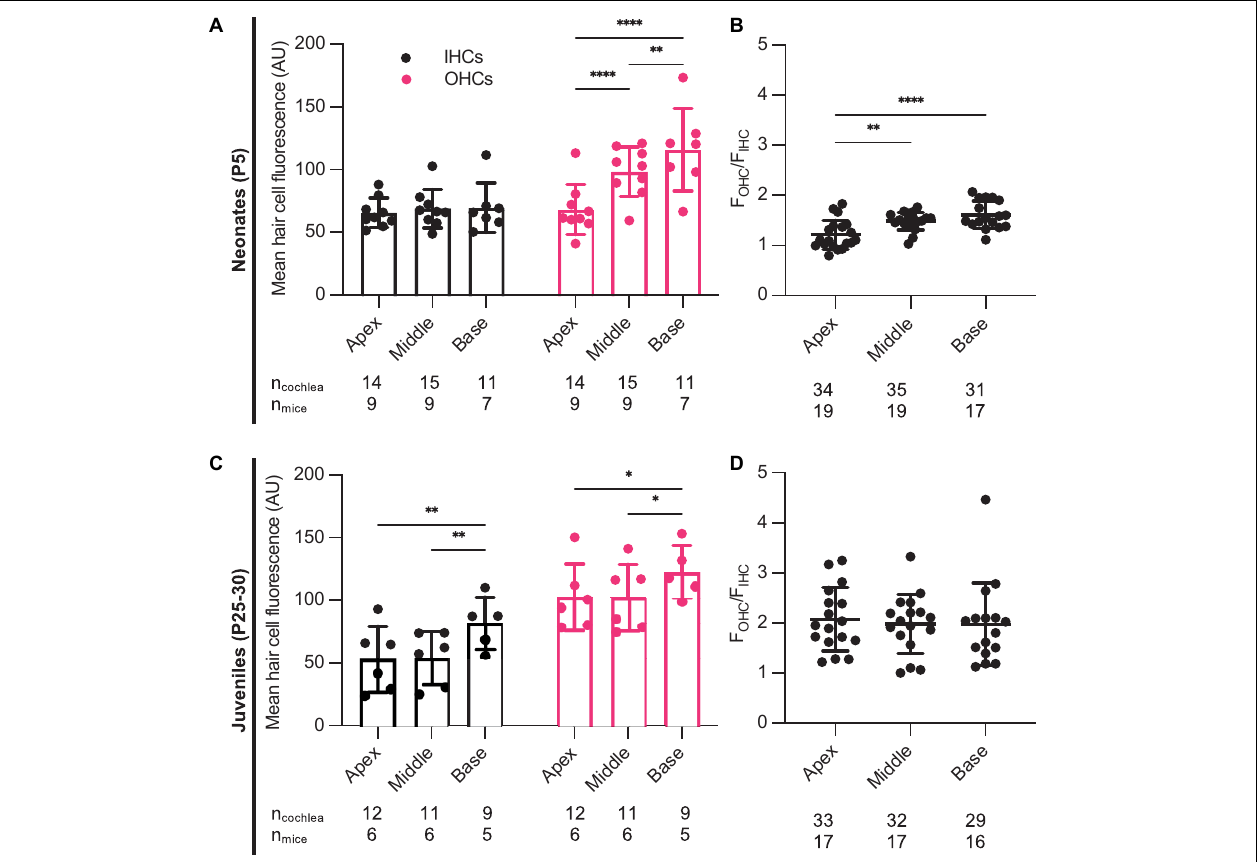
FIGURE 3 | Characteristics of G418-TR uptake in neonatal and juvenile hair cells. (A) Pooled analysis of the ratio of OHC to IHC uptake (F OHC /F IHC ) was calculated for all neonatal animals treated with G418-TR (2.5, 5, and 10 mg/kg) and sorted by tonotopic region. In neonatal hair cells, there is significant variation in F OHC /F IHC by region [Mixed-effects Analysis; F ( 2 , 52 ) = 11.81, P < 0.0001]. (B) Pooled analysis for all juvenile animals treated with G418-TR (5, 10, and 20 mg/kg) demonstrates no significant tonotopic variation in F OHC /F IHC [Mixed-effects Analysis; F ( 2 , 31 ) = 0.1442, P = 0.8662]. n cochlea and n mice represent the number of cochlea and mice examined, respectively. When two cochlea from the same animal were analyzed, the animal mean was calculated and used for all statistics and graphs. Error bars are standard deviations. ∗∗ P < 0.01, ∗∗∗∗ P < 0.0001; P -values generated from multiple comparisons post hoc test (Tukey’s multiple comparison